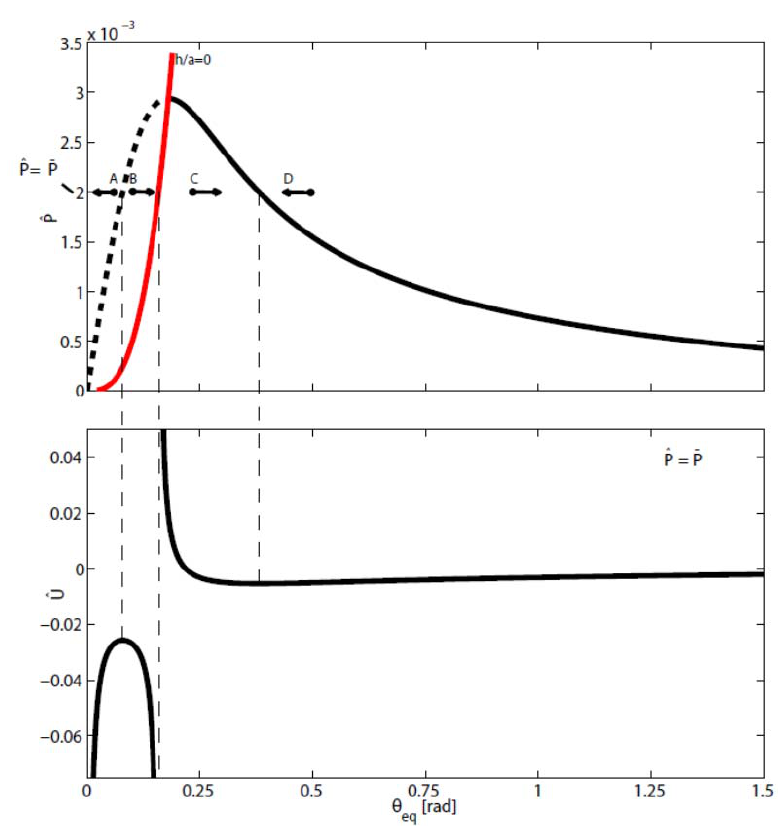
 (a); the total energy as a function of the eq